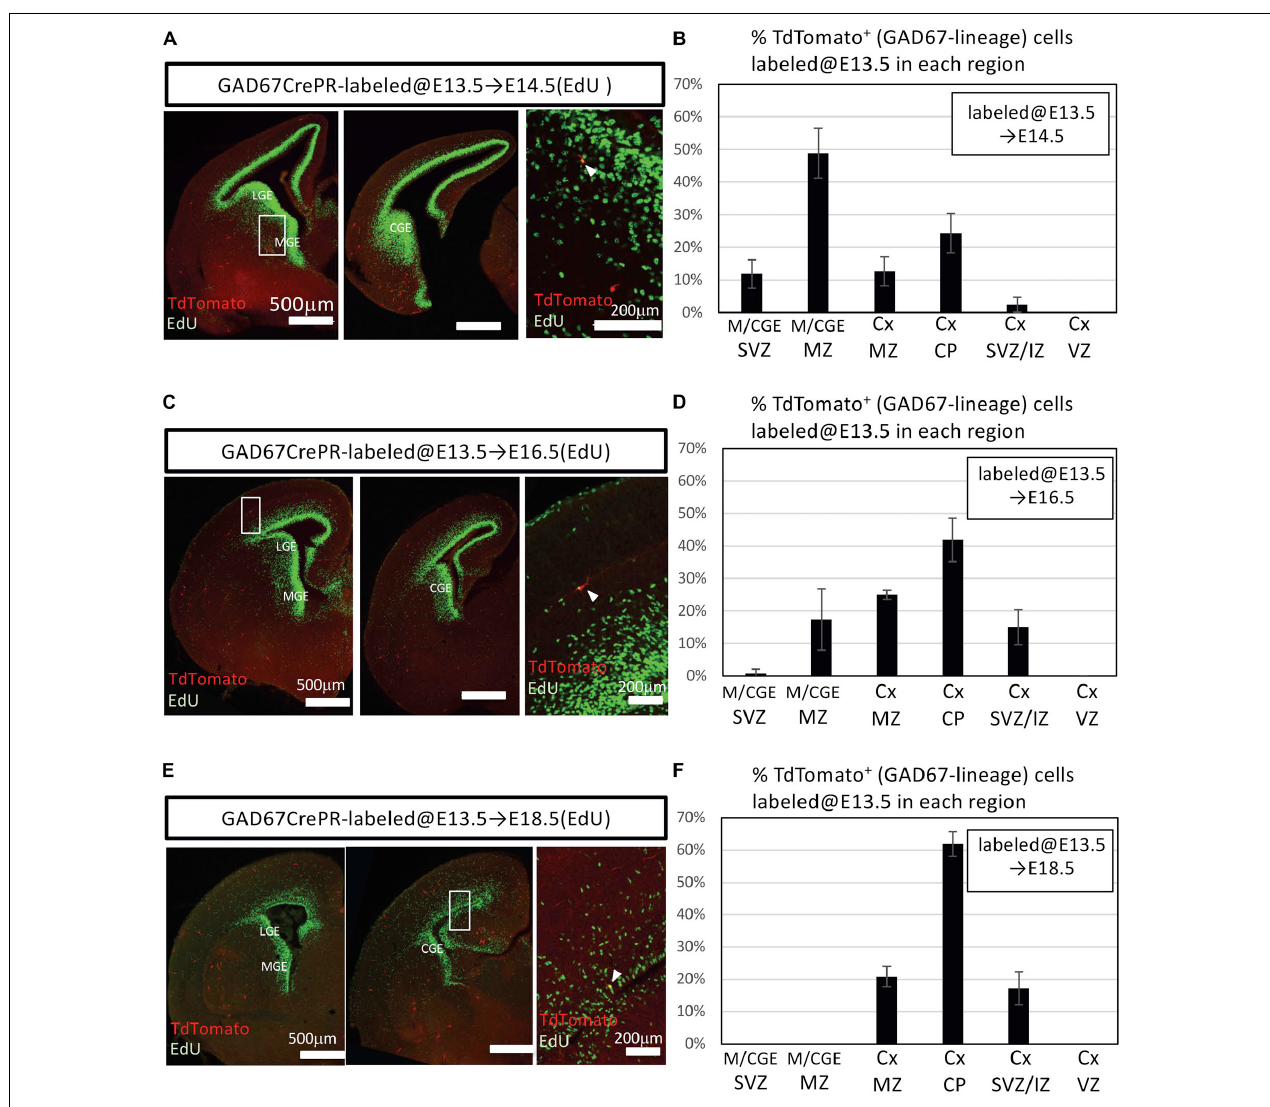
FIGURE 4 | Embryonic proliferation of GAD67-lineage cells. (A) Coronal section of a GAD67-CrePR;Ai9 mouse brain at E14.5 with EdU staining (green). Mifepristone was administered to pregnant GAD67-CrePR;Ai9 mice at E13.5, and EdU was injected i.p. 30 min before fixation. Middle image shows higher magnification of region outlined with white boxes in left column. White arrowhead indicates a double-positive cell in SVZ of MGE. Ctx, cortex; MGE, medial ganglionic eminence; LGE, lateral ganglionic eminence; CGE, caudal ganglionic eminence. (B) Percentages of TdTomato + cells (GAD67 lineage labeled at E13.5) labeled with EdU (E14.5) in each region. Error bars represent SDs ( n = 3 brains). Ctx, cortex; M/CGE, medial/caudal ganglionic eminence; MntZ, mantle zone; MrgZ, marginal zone; CP, cortical plate; SVZ/IZ, subventricular zone/intermediate zone; VZ, ventricular zone. (C) Coronal section of a GAD67-CrePR;Ai9 mouse at E16.5 with EdU staining (green). Mifepristone was administered to pregnant GAD67-CrePR;Ai9 mice at E13.5, and EdU was injected i.p. 30 min before fixation. Middle image shows higher magnification of region outlined with white box. White arrowhead indicates a double-positive cell in cortical plate. (D) Percentages of TdTomato + cells (GAD67 lineage labeled at E13.5) labeled with EdU (E16.5) in each region. Error bars represent SDs (n = 3 brains). (E) Coronal section of a GAD67-CrePR;Ai9 mouse brain at E18.5 with EdU staining (green). Mifepristone was administered to pregnant GAD67-CrePR;Ai9 mice at E13.5, and EdU was injected i.p. 30 min before fixation. White arrowhead indicates a double-positive cell in SVZ/IZ. (F) Percentages of TdTomato + cells (GAD67 lineage labeled at E13.5) labeled with EdU (E18.5) in each region. Error bars represent SDs ( n = 3